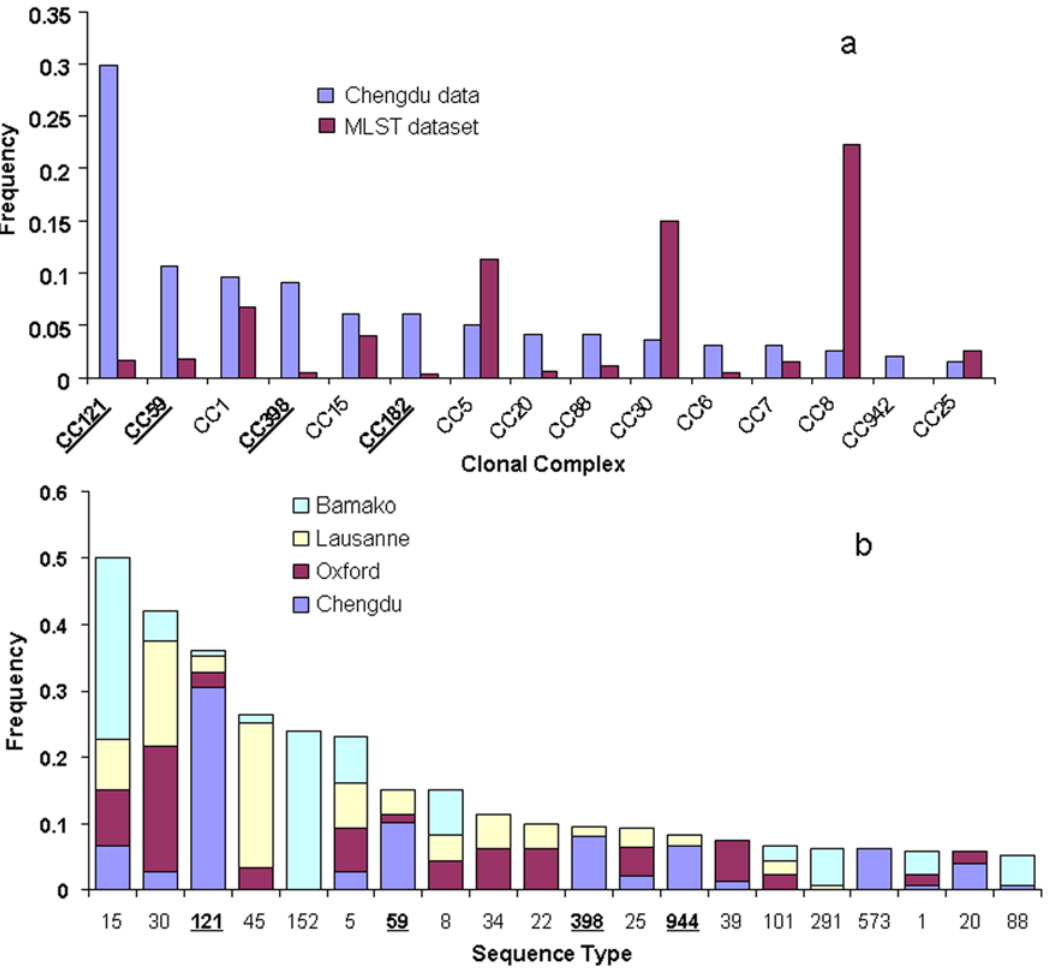
Figure 1.a Thefrequencies of the clonal complexes in thecombined disease and carriage dataset, and the corresponding frequencies inthe MLST website are given. The clonal complexes were delineated using eBURST on the Chengdu data separately (198 isolates) and on the whole MLST dataset. eBURST also outputs the number of isolates belonging to the complex which was used to calculate the frequencies. CCs121, 59, 398 and 182 are all over-represented in the Chengdu data (in bold and underlined). These complexes are related, and all correspond to the major phylogenetic clade Group 1b (see text). In contrast, CCs 5 and 8 are under-represented in the Chengdu data (Group 2), as is CC30 (Group 1a). 1b Comparison of the frequencies of STs within the Chengdu carriage isolates with previous studies of carriage in Europe and Africa (see text for references). Only STs with an average frequency of . 1% over the four datasets were included. These comparisons confirm the atypical genotype frequencies noted above (note: ST944=CC182, ST573=CC1).